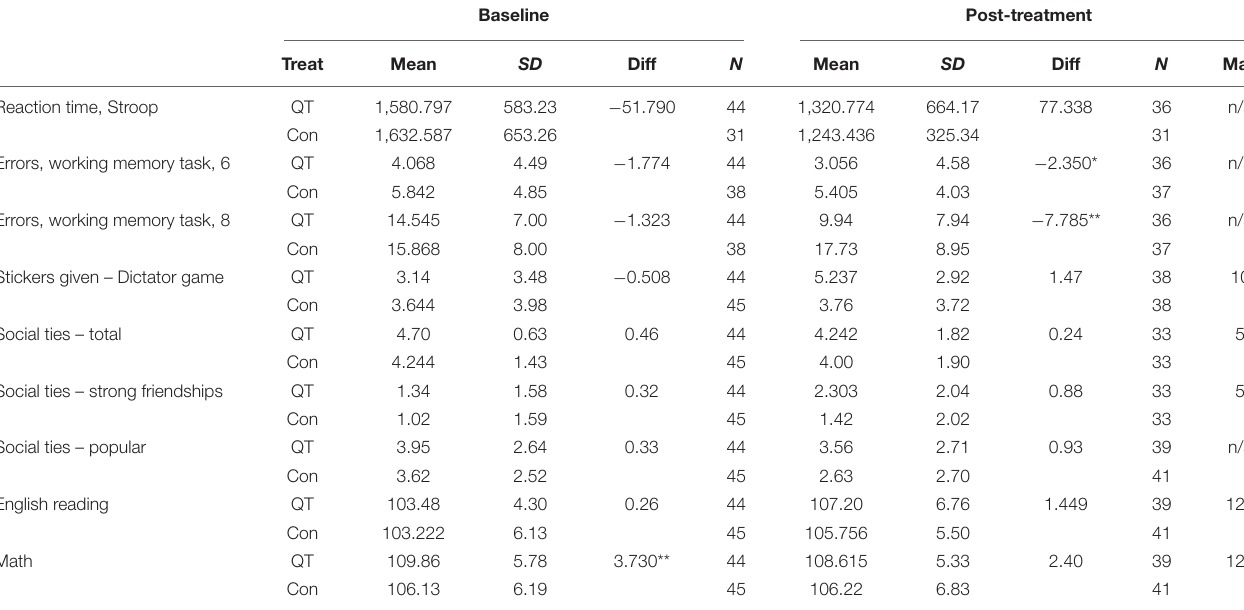
TABLE 3 | Descriptive statistics of the outcome variables before and after the intervention in the United Kingdom setting. Baseline Post-treatment